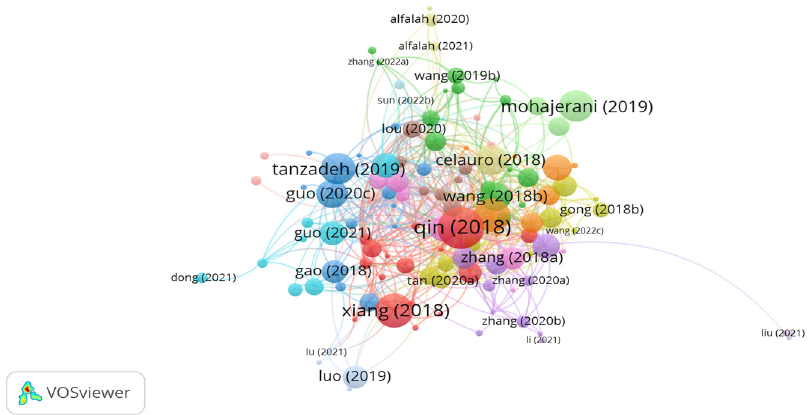
Figure 4. Network visualization of basalt fibers.